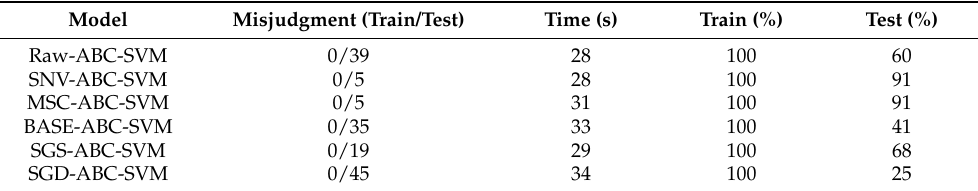
Table 2. The ABC-SVM classification models established by the original Ranman spectra and the Ranman spectra after five different kinds of pretreatments.